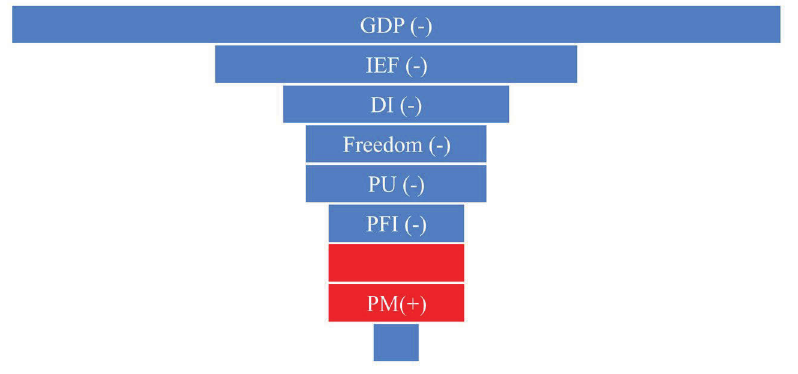
Fig. 4. Relative impact of covariates on EI with treatment